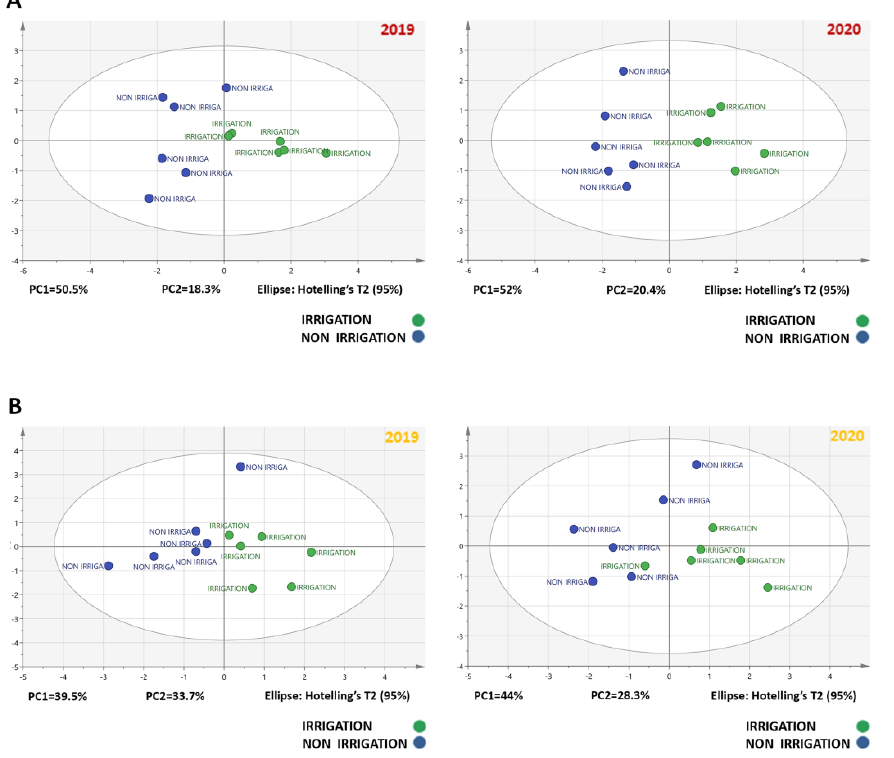
Figure 4. Classification using PCA plot with “irrigation treatment” as depended variable on quality berry characteristics (chemical and anthocyanins- total phenols) data from grape berries cv. Agior- gitico ( A ) and Assyrtiko ( B ) at harvest stage in 2019 and 2020 vintages. Variables in score plots are colored according to the irrigation treatment.